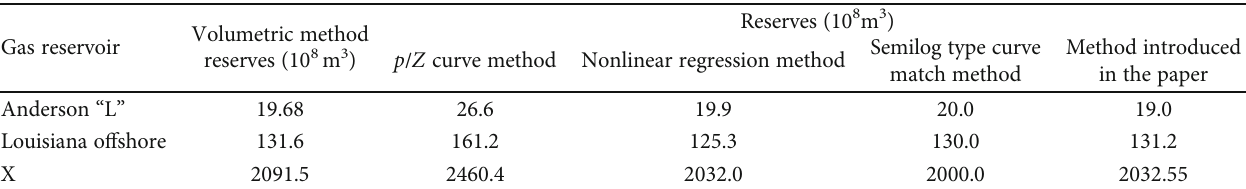
Table 5: Comparison of reserves calculated by di ff erent